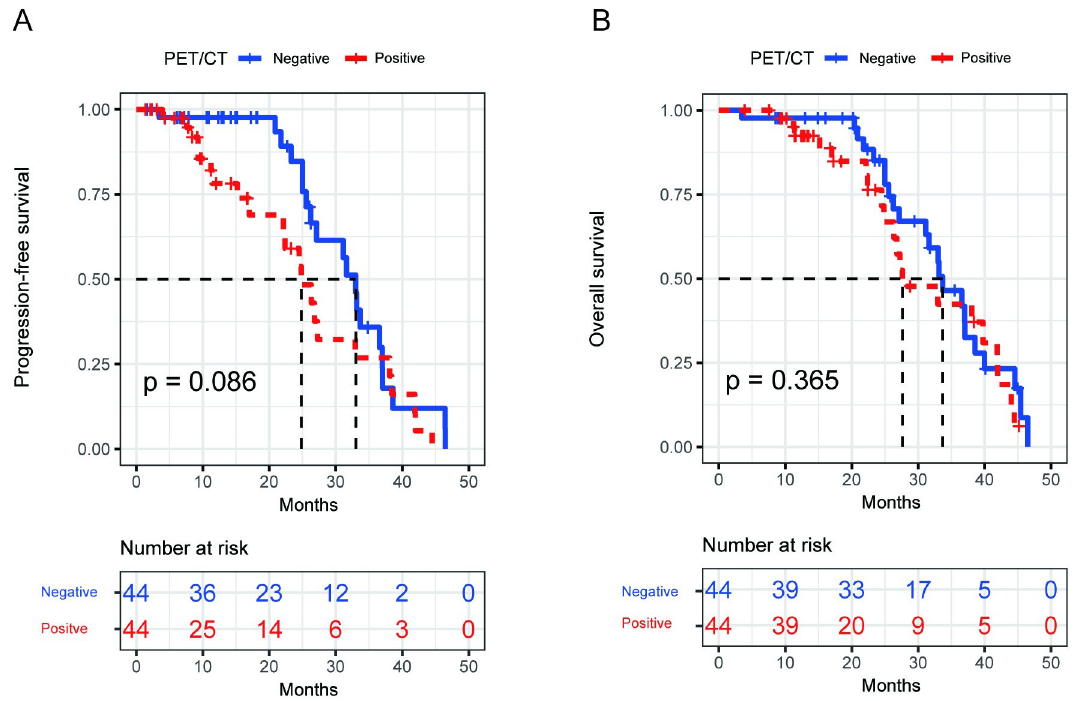
Fig 8. Survival curves of patients diagnosed using positron emission tomography-computed tomography after propensity-score matching. (A): Progression-free survival curve. (B): Overall survival curve.